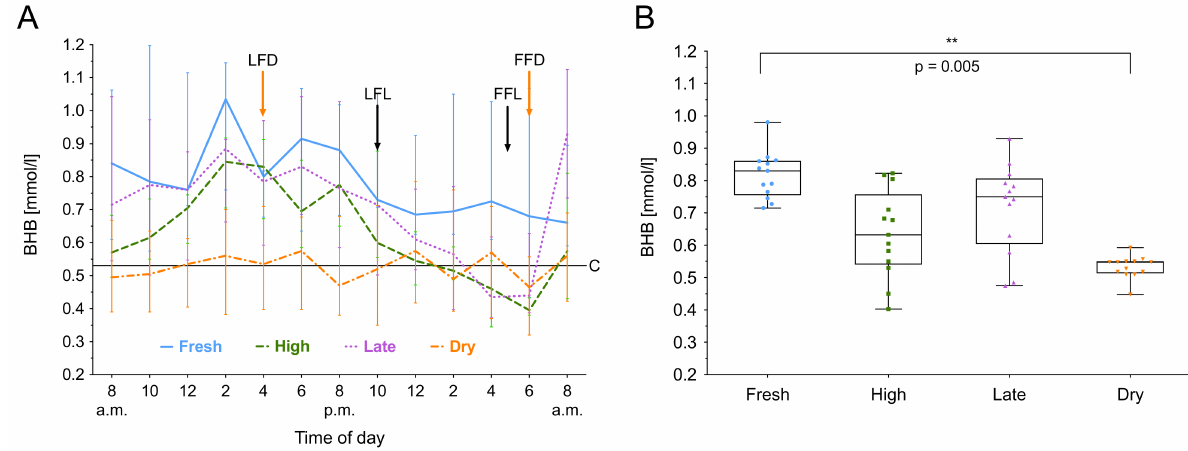
Figure 3. Beta-hydroxybutyrate (BHB) concentration in serum over 24 h. ( A ) Data expressed as group median with the interquartile range as error bars. Last and first feeding of the day and cut off level for group investigations [9] are shown. Black color indicates lactating cows, orange represents dry cows. LFL: last feeding of lactating cows; FFL: first feeding of lactating cows; LFD: last feeding of dry cows; FFD: first feeding of dry cows; C: Cut off level for all cows. ( B ) Within-group distribution of BHB concentration in serum over 24 h. The box depicts the median and the lower and upper quartile. The whiskers show minimum and maximum values. Bracket represent Tukey adjusted pairwise comparisons between lactation group means.